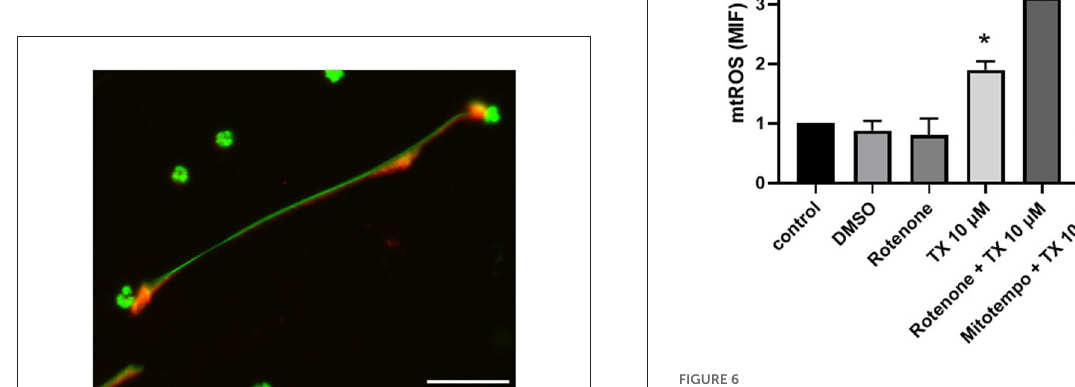
FIGURE6 Tamoxifen induces mitochondrial ROS production. Equine neutrophils were stained with Mitosox and incubated with tamoxifen (10 uM), rotenone (10 uM), mitotempo(200 uM) or vehicle (DMSO 0.1%) for 30min at 37 ◦ C. Where indicated, prior to the addition of tamoxifen (10 uM) the neutrophils were preincubated with rotenone (10 uM) or mitotempo (200 uM) for 30min at 37 ◦ C. The mean fluorescence intensity (MIF) was analyzed by flow cytometry. The result corresponds to the average + /- S.E.M of 5 independent experiments. * p < 0.05; ** p < 0.01.